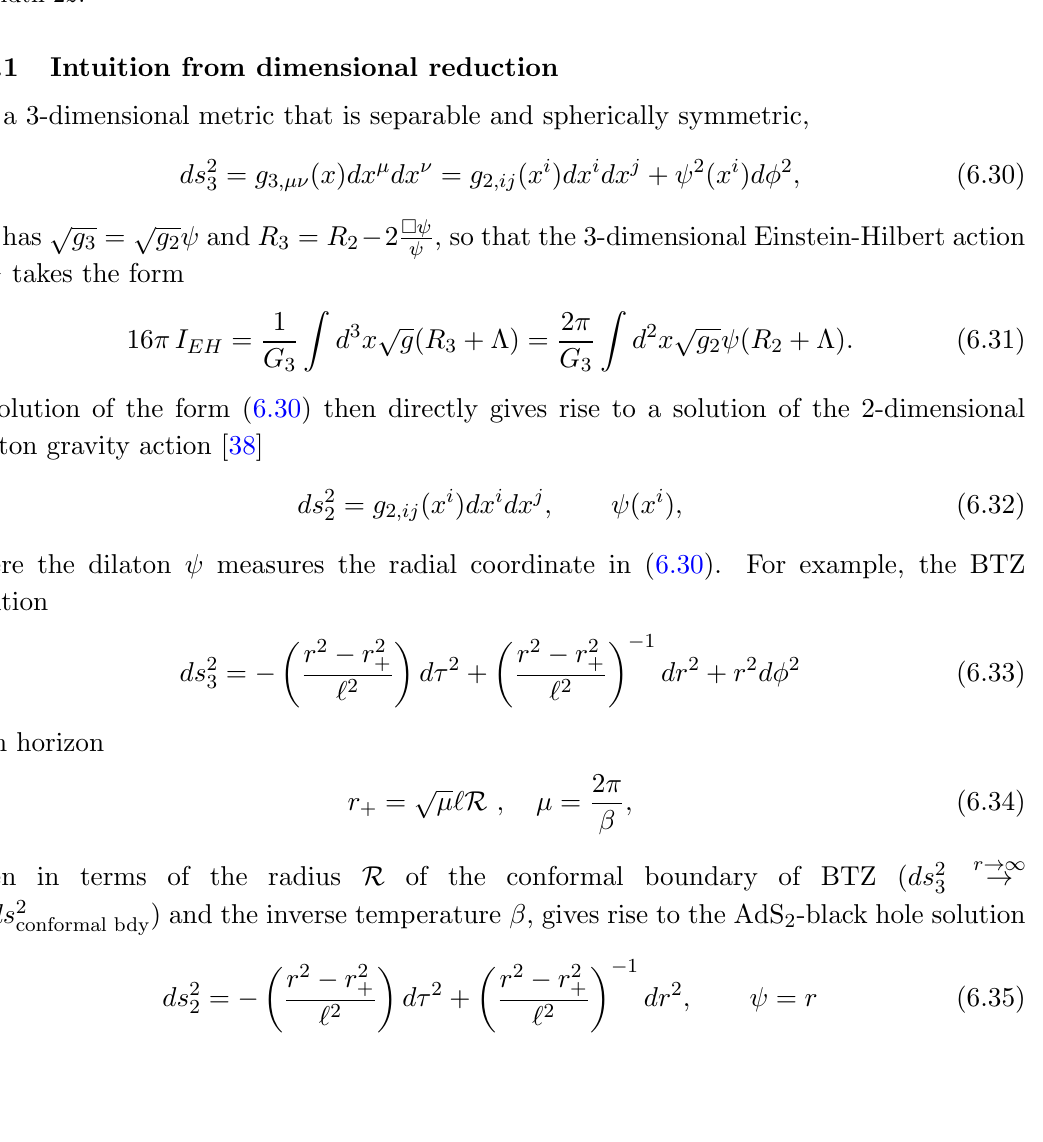
Figure 5 . Left : dilaton as di(cid:11)erential entropy (6.29) from considering the parent asAdS 3 theory with possible horizon at r = r + . This relates the dilaton with the entanglement of the interval in blue, di(cid:11)erent from the interpretation (6.25) that relates the dilaton with the entanglement of the interval in blue in (cid:12)gure 4 (right). Right : di(cid:11)erential entropy measures ‘entanglement’ of the strip of width 2 z